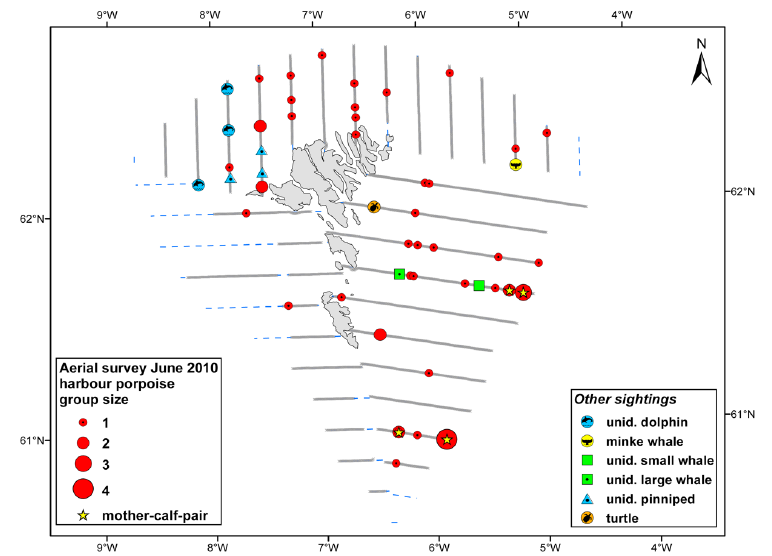
Figure 6. Realised effort (grey line) and harbour porpoise sightings during the 2010 Faroese survey. Other species sightings are indicated as well. Uncovered transects and segments in the inshore strata are indicated as dashed blue